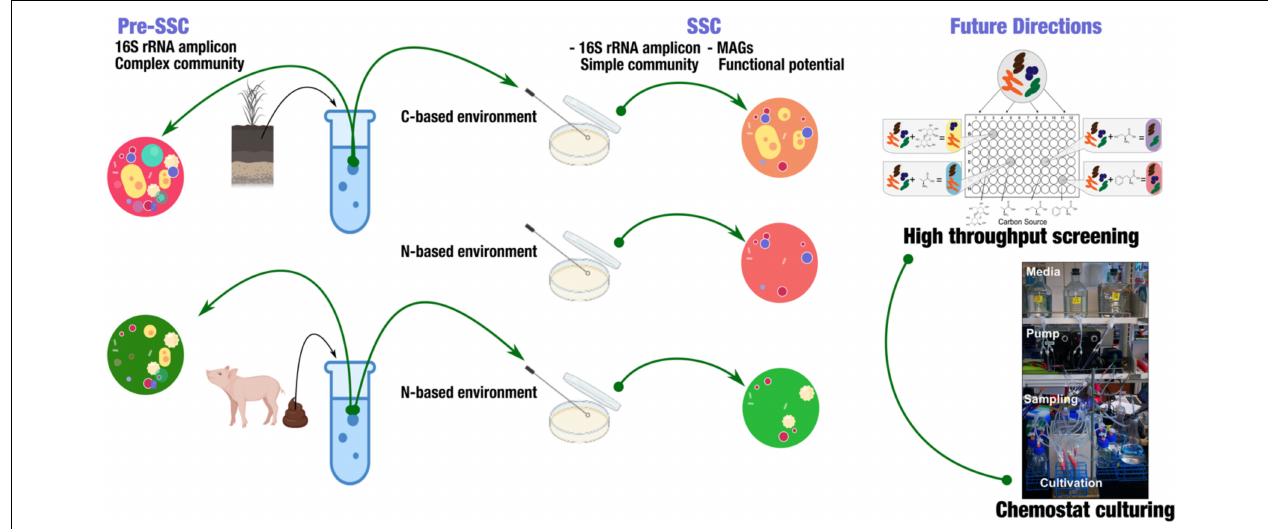
FIGURE 1 | Experimental strategy to obtain simple state communities (SSC) from soil and fecal samples. This strategy highlighted obtaining a simple, targeted community that enabled the further investigation of functional potential in metagenome-assembled genomes (MAGs). Further applications include high-throughput screening of SSC using BIOLOG R (cid:13) system and continuous culturing